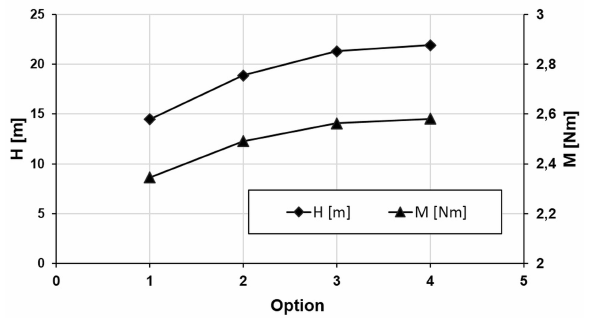
Figure 7: Influence of the grid size on the value of key computa- tional